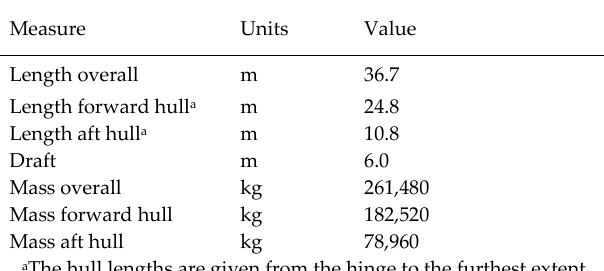
Fig. 3. The Mocean M100 WEC as a CAD model used to compute hydrodynamic coefficients in